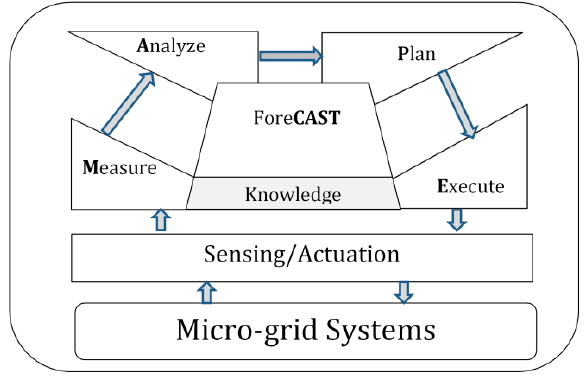
Figure 9. The proposed control approach schemes with operation process.